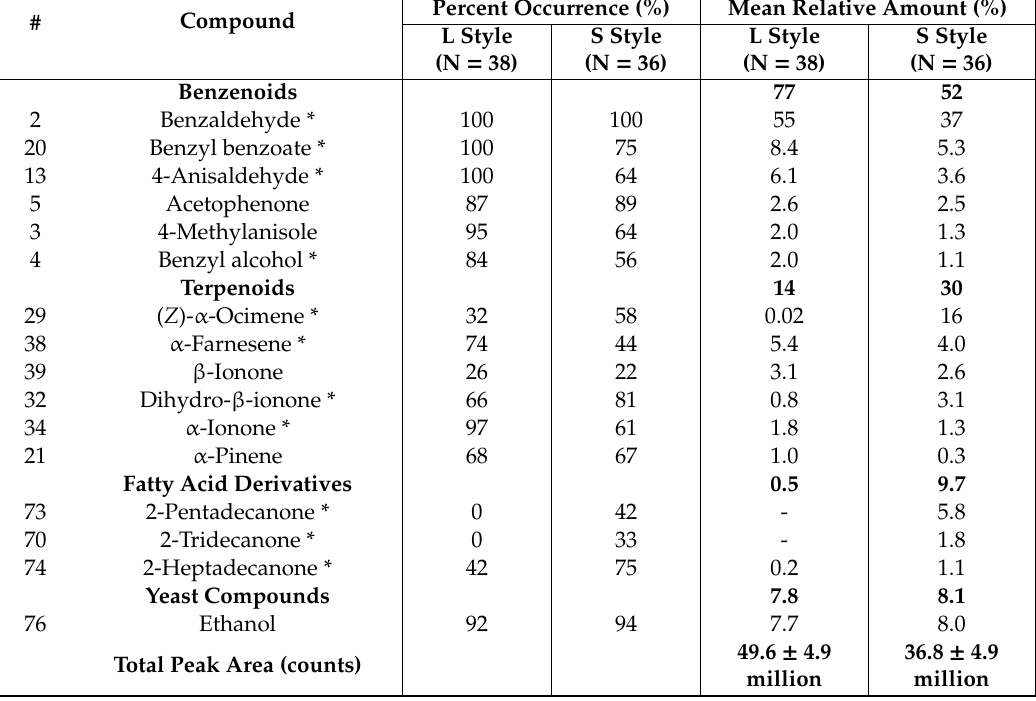
Table2. Major( > 1%)floralscentcompoundsin G.sempervirens inorderofrelativeamounts. Compounds with significantly di ff erent relative amounts in L verses S flowers ( p < 0.05) are indicated with an